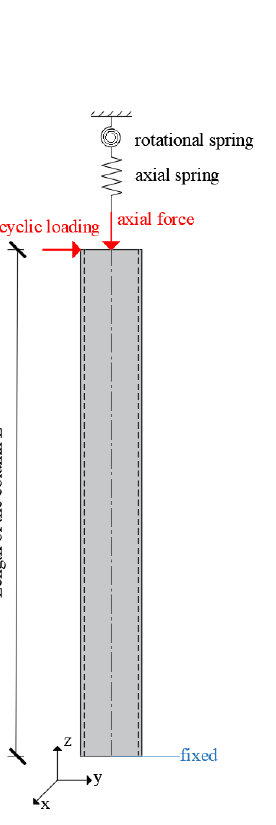
Figure 1. The axially and rotationally restrained steel column and the numerical model.